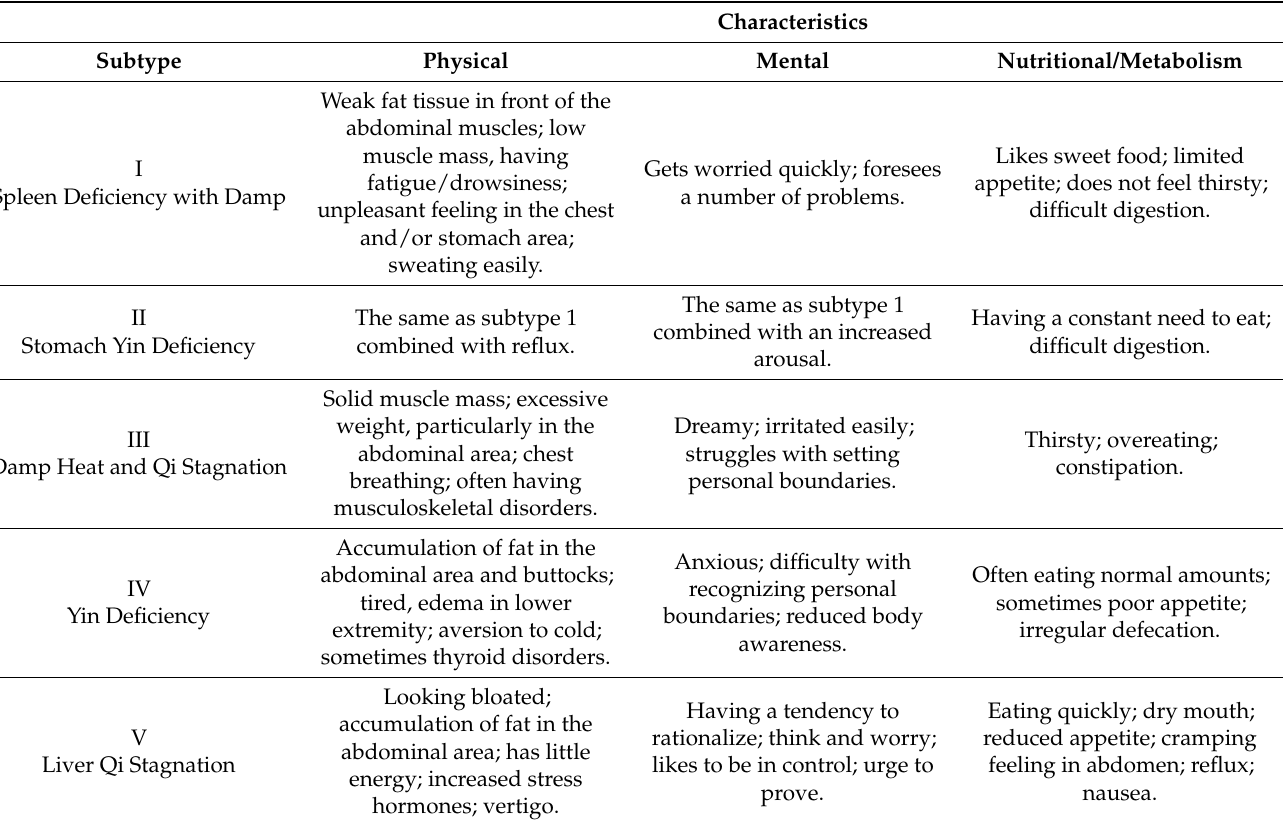
Table 1. Chinese subtypes of obesity divided into physical, mental, and food/metabolism character- istics based on two textbooks of Chinese medicine